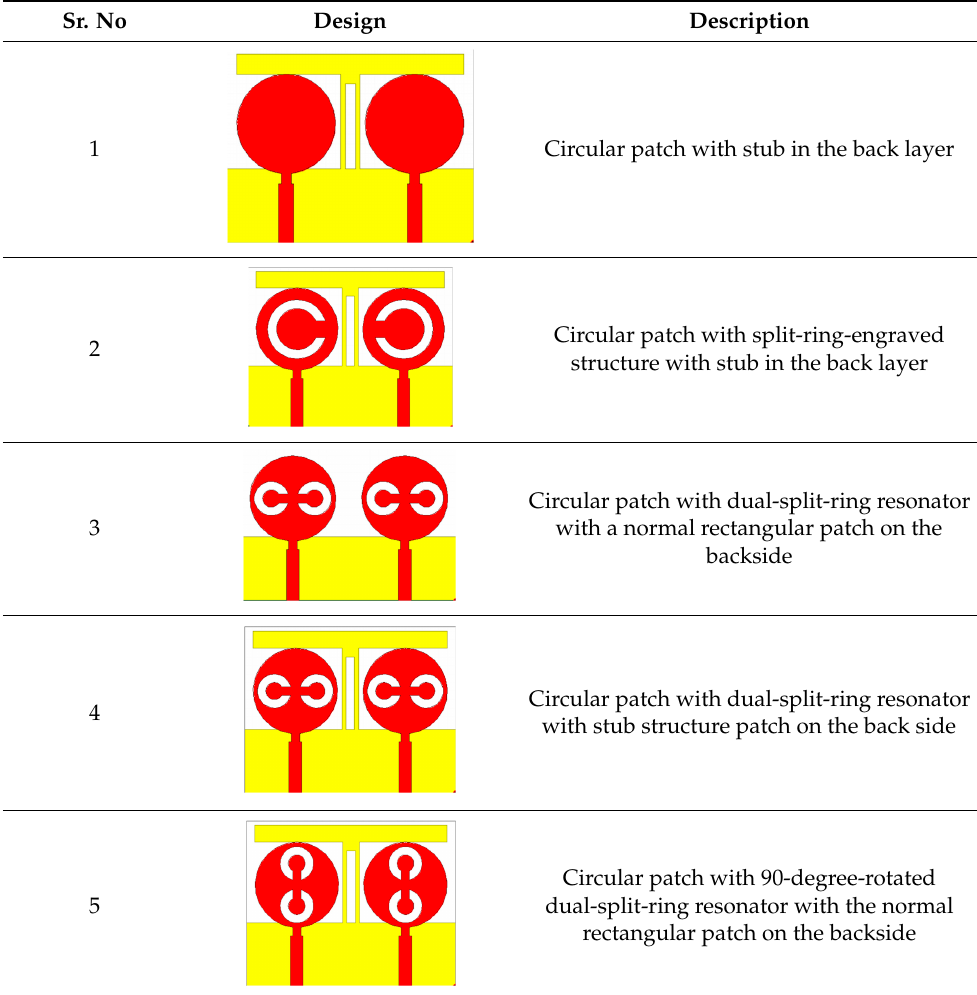
Table 2. Different antenna designs and their descriptions.